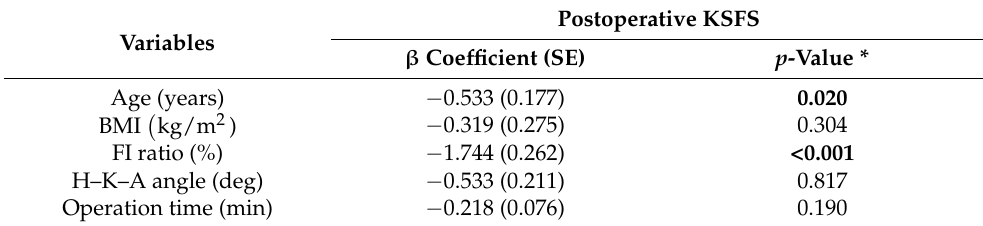
Table 2. Multivariate linear regression analysis of variables associated with postoperative